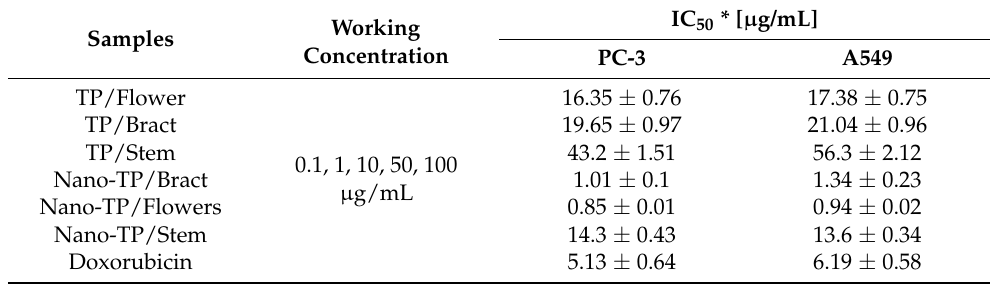
Table 4. IC 50 values of different fractions of total phenolics and their AgNPs forms of different